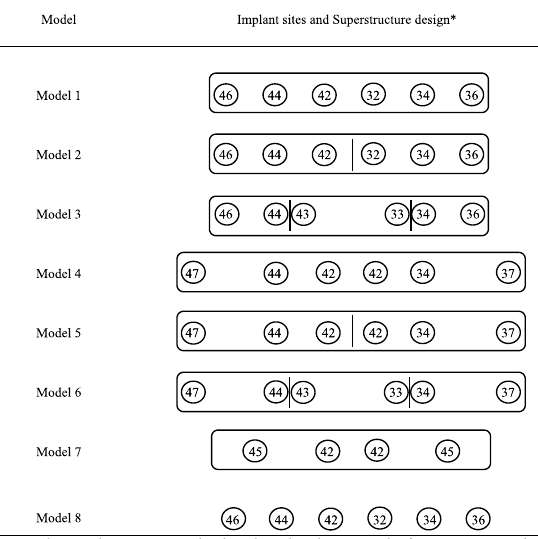
a The circular number represents the dental implant location. The frame represents the segmented design of the superstructure, that is, models 1 and 4 are one-stage superstructures;models2and5aretwo-stagesuperstructures;models3and6arethree- stagesuperstructures;model7isdesignedforall-on-four;model8hasnosuperstructure for reference. The sites of implants were placed 12 mm (32, 42), 21.2 mm (33, 43), 32.7 mm (34, 44), 45.6 mm (35, 45), 60 mm (36, 46), and 77.5 mm (37, 47) from the midline, respectively, on each